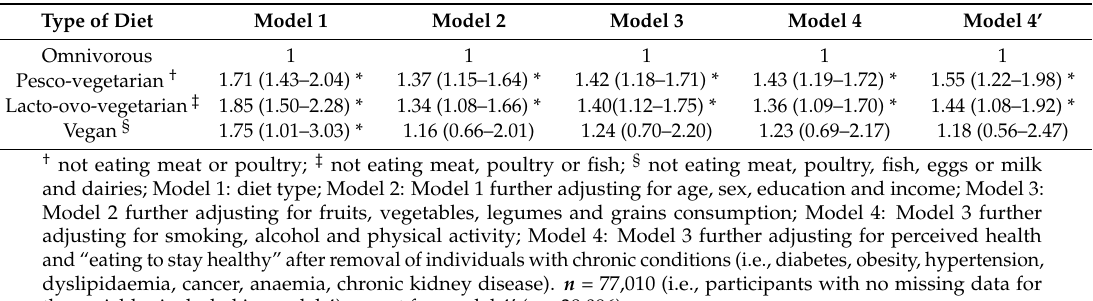
Table 2. Odds-Ratios (95% confidence interval) for the association of diet type with depressive symptoms in logistic regressions.